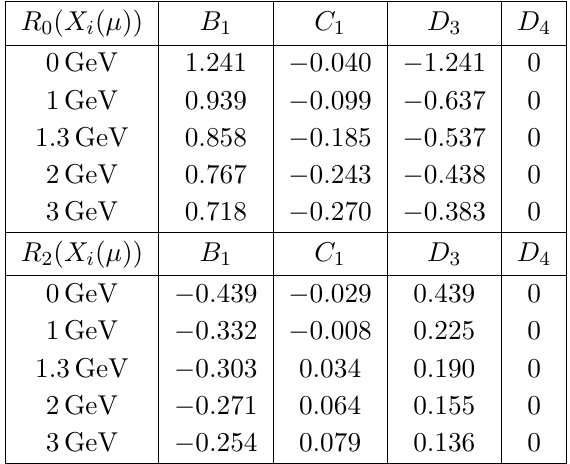
(cid:2) U(1) Q but not by c